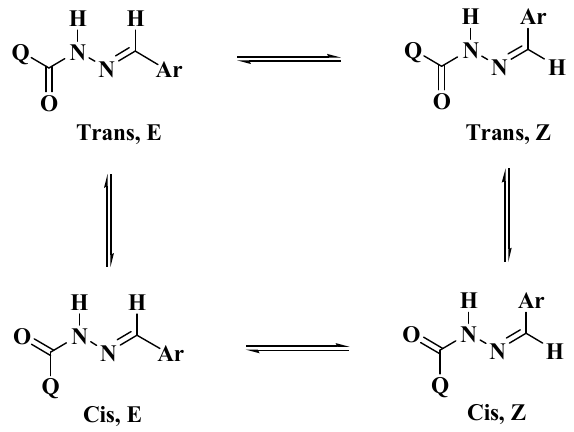
Scheme 2. E/Z geometrical isomers and cis/trans conformers for hydrazones.